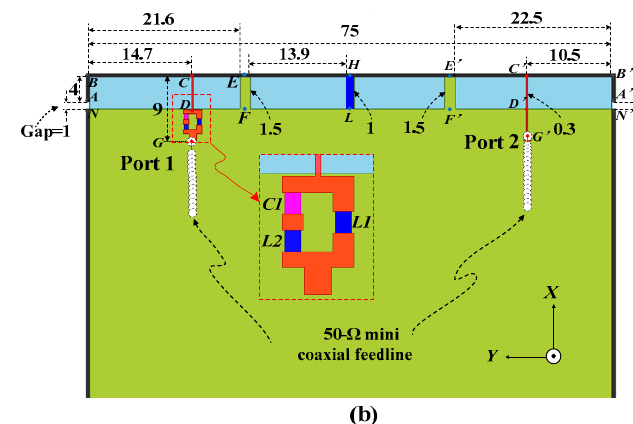
Figure 1. The dual-antenna system configuration: ( a ) geometry; ( b ) detailed dimensions (in mm).